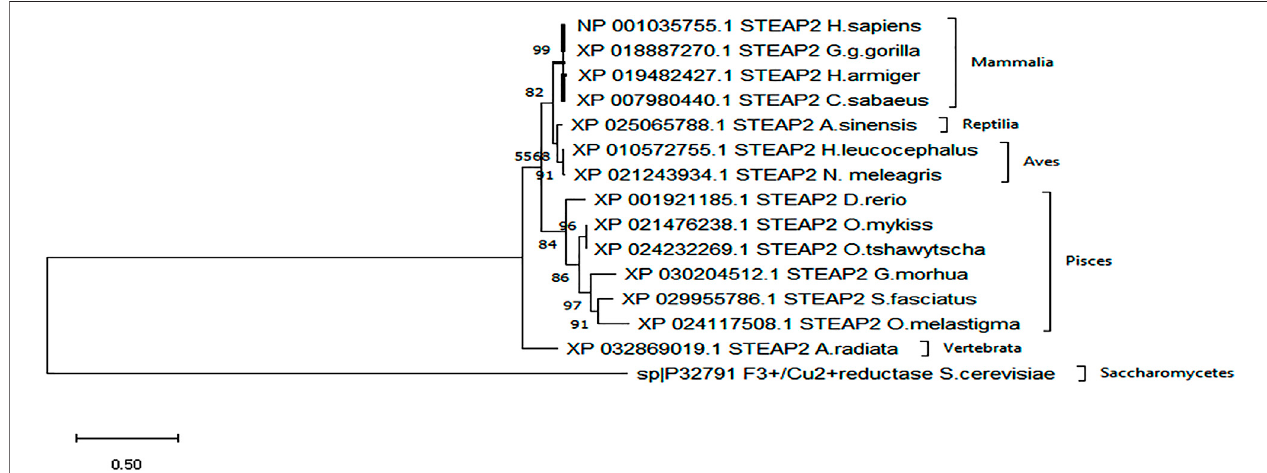
FIGURE4| Fromthephylogenetictree,whichisaresultof1,000bootstraps,itisshownthattheSTEAP2proteinfrom G.gorilla (mammal)ismostrelatedtohuman STEAP2 from 99% of the 1,000 redrawn trees and the least related is A. radiata . The fi rst four listed species from top belong to class Mammalia, followed by an alligator (Reptilia), birds (Aves) fi sh (Pisces), and a turtle (Vertebrata) all under phylum Chordata.